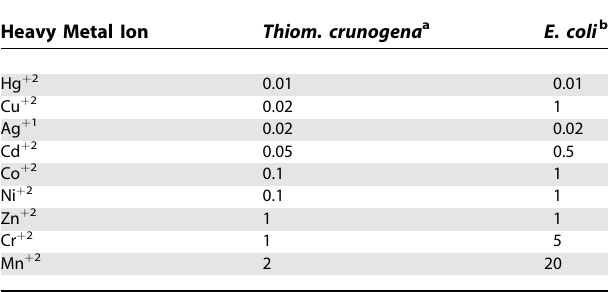
Table 3. Growth-Inhibiting Concentrations (mM) of Heavy Metals for Thiom. crunogena XCL-2 and E.